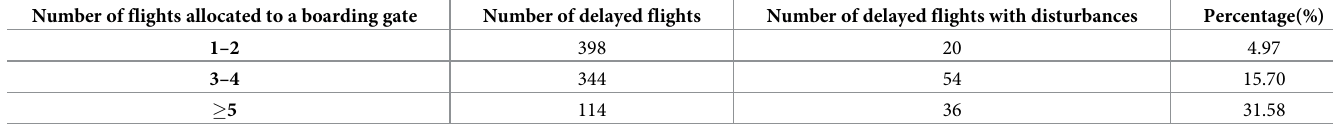
Table 3. Statistics on the number of delayed flights allocated to boarding gates and passenger disturbances at Shenzhen Airport, 2018. Number of flights allocated to a boarding gate